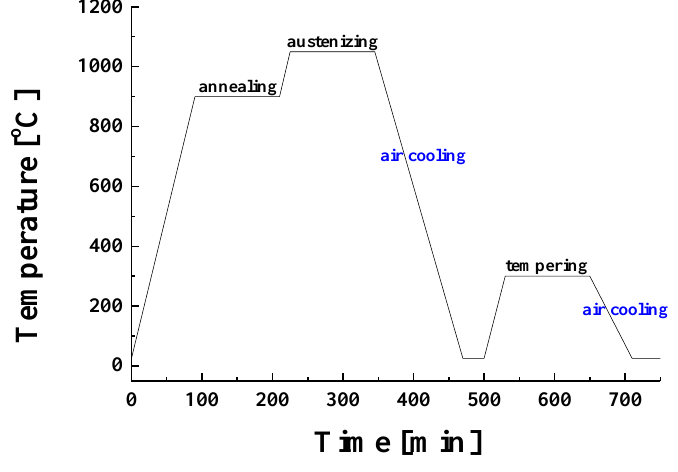
Figure 1. Heat treatment cycle.